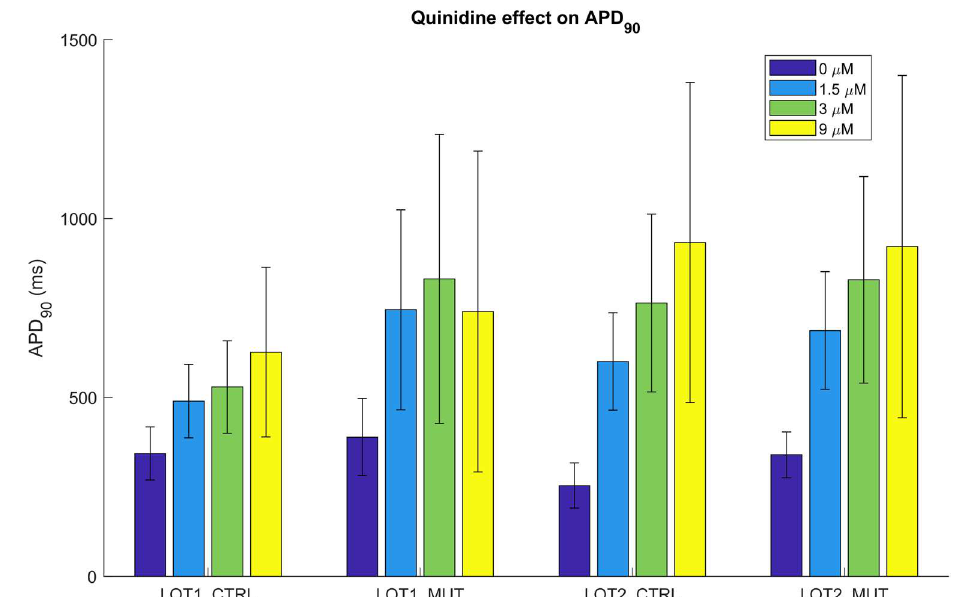
Figure 11. APD 90 quinidine–induced prolongation in the four in silico populations. APD 90 values were computed only for the models that did not develop abnormalities in response to quinidine administration. Error bars represent the standard deviation.